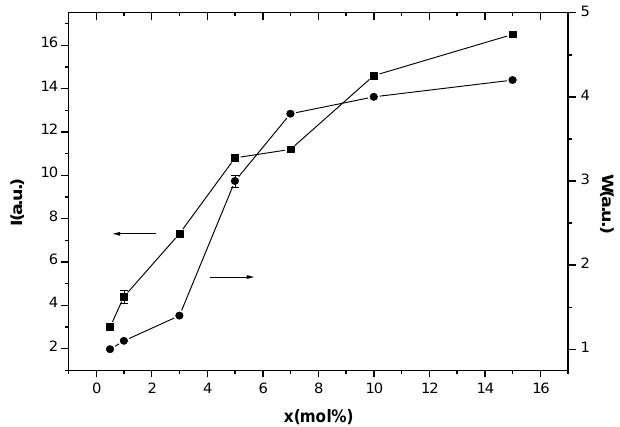
Figure 3. Composition dependence of intensity and line-width of EPR absorption of (CuNPs) x · (P 2 O 5 ) 35 · (Sb 2 O 3 ) (64 − x) · (Sm 2 O 3 ) 1 glasses. The lines are drawn as a visual guide.